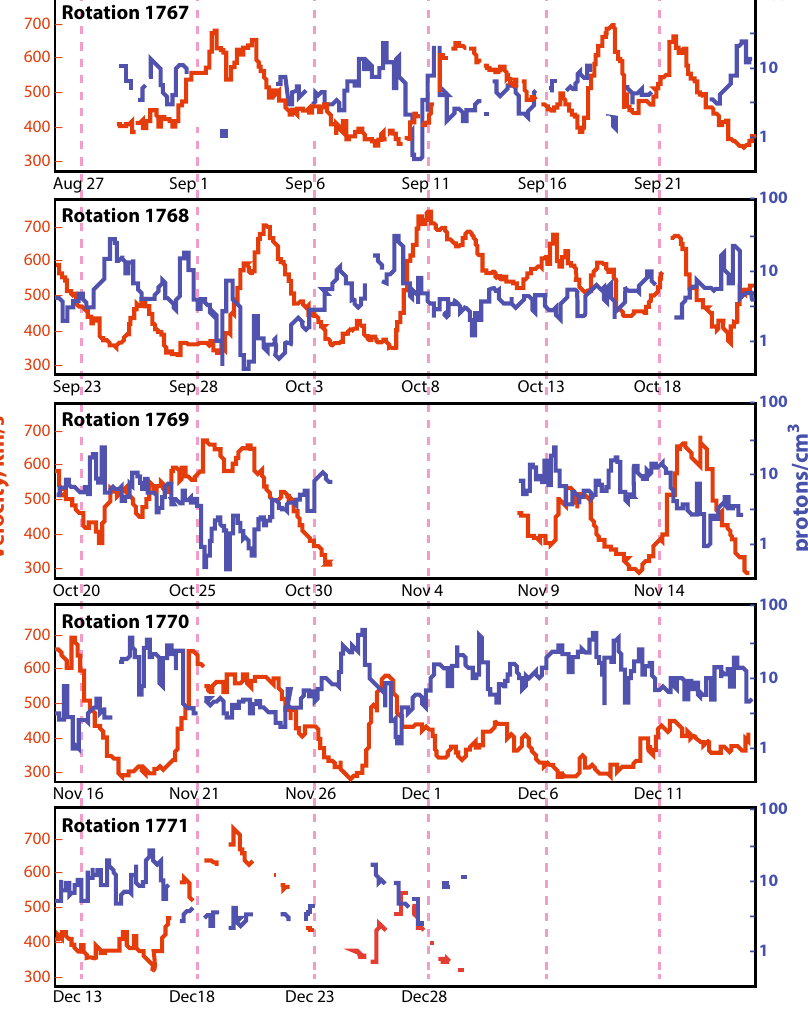
3 First numerical models of the solar